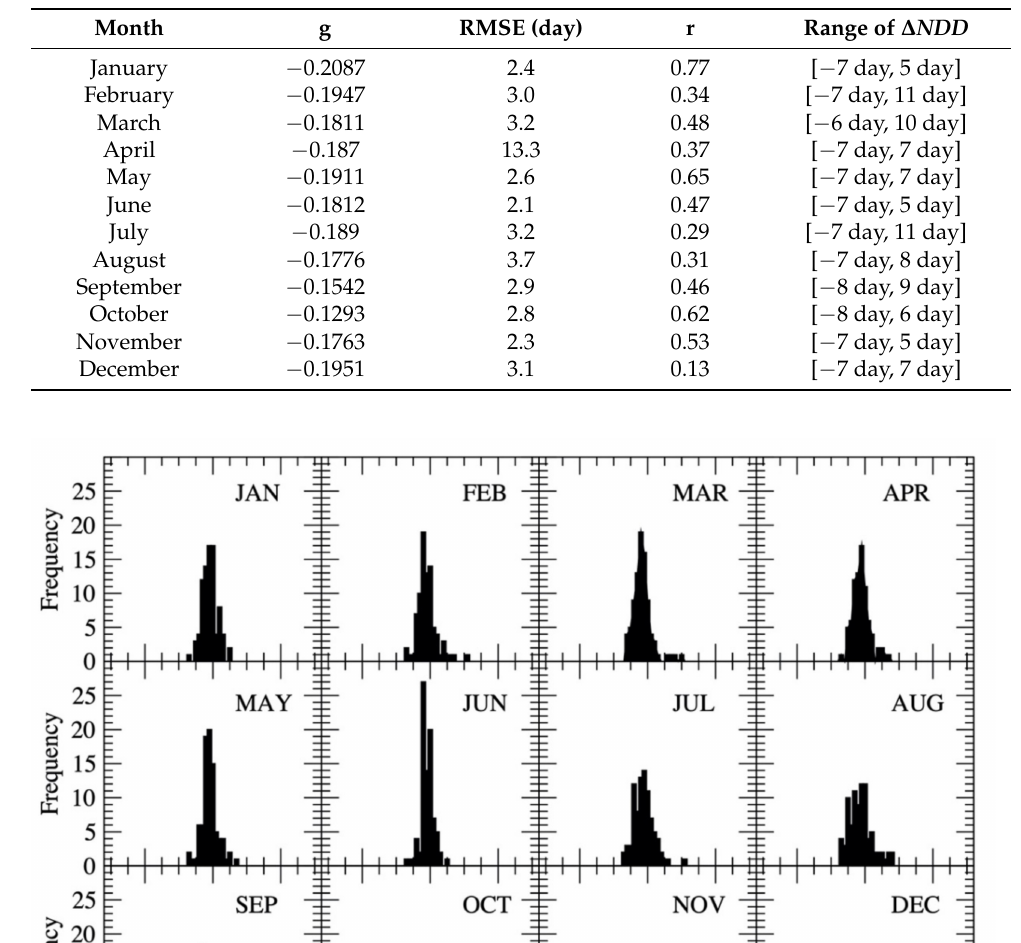
Table 4. Statistics of the linear regression of MP vs. NDD .